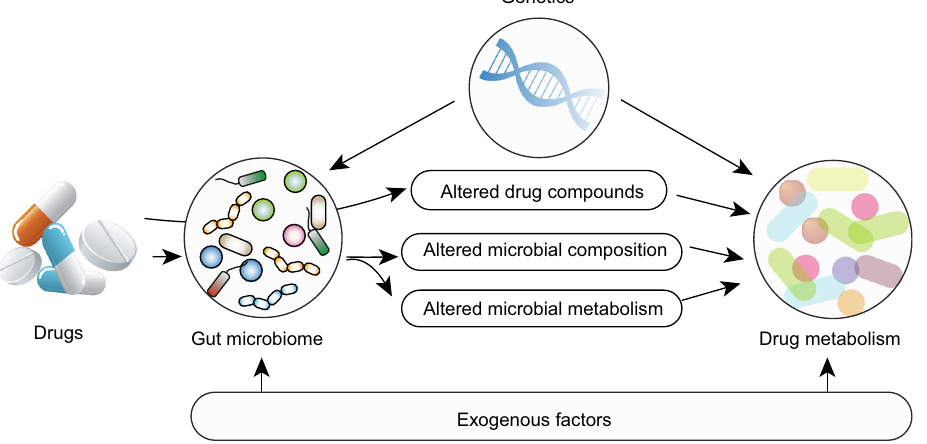
Figure 4. Host-microbe-diet interactions in drug metabolism. Complex drug-microbe interactions can result in alterations in microbial composition and function and change the chemical structure of compounds that could directly or indirectly affect drug metabolism in the liver. Moreover, genetics and exogenous factors, including diet, can affect both gut microbiome and drug metabolism in the